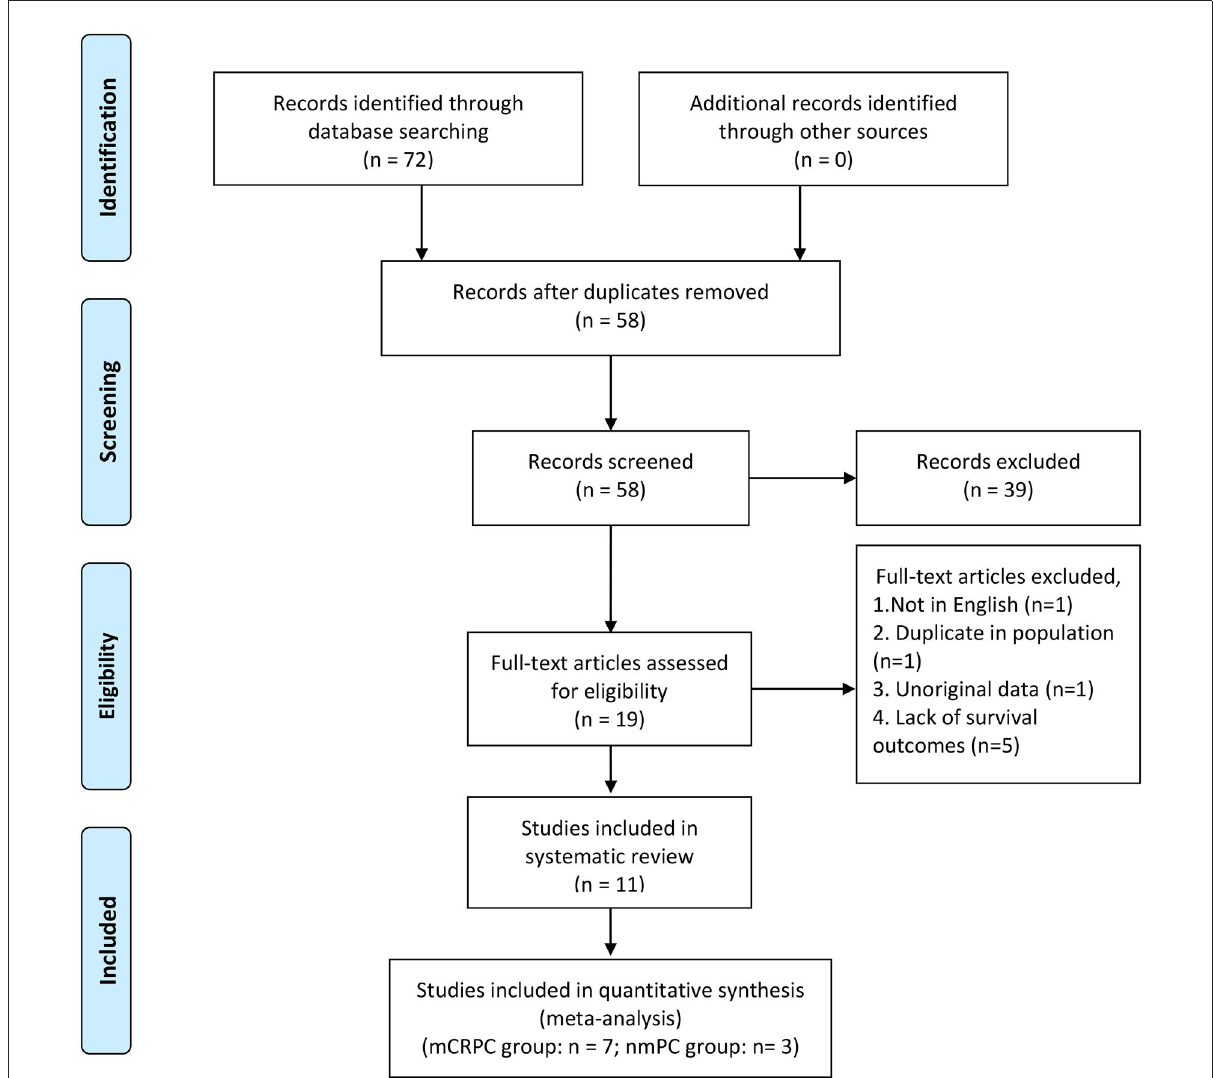
FIGURE1 PRISMA flow diagram of literature retrieval. PRISMA, Preferred Reporting Items for Systematic Reviews and Meta-Analyses.